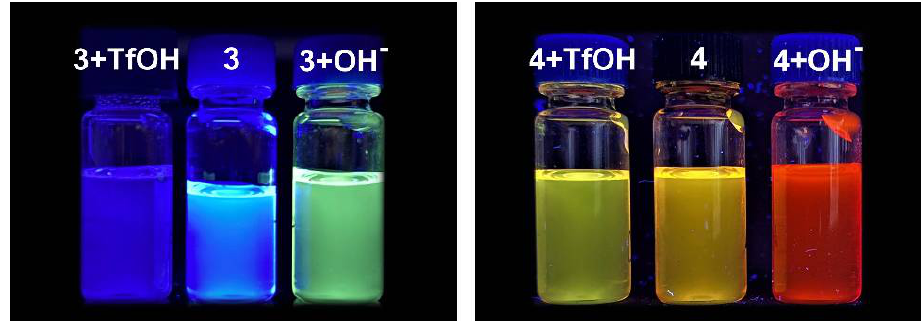
Figure 6. Fluorescence color changes of 3 (left) and 4 (right) at 10 −4 M in the presence of 2 equiv. of TfOH or 2 equiv. of TBAOH in DMSO + 0.5% H 2 O observed under a UV lamp (365 nm).